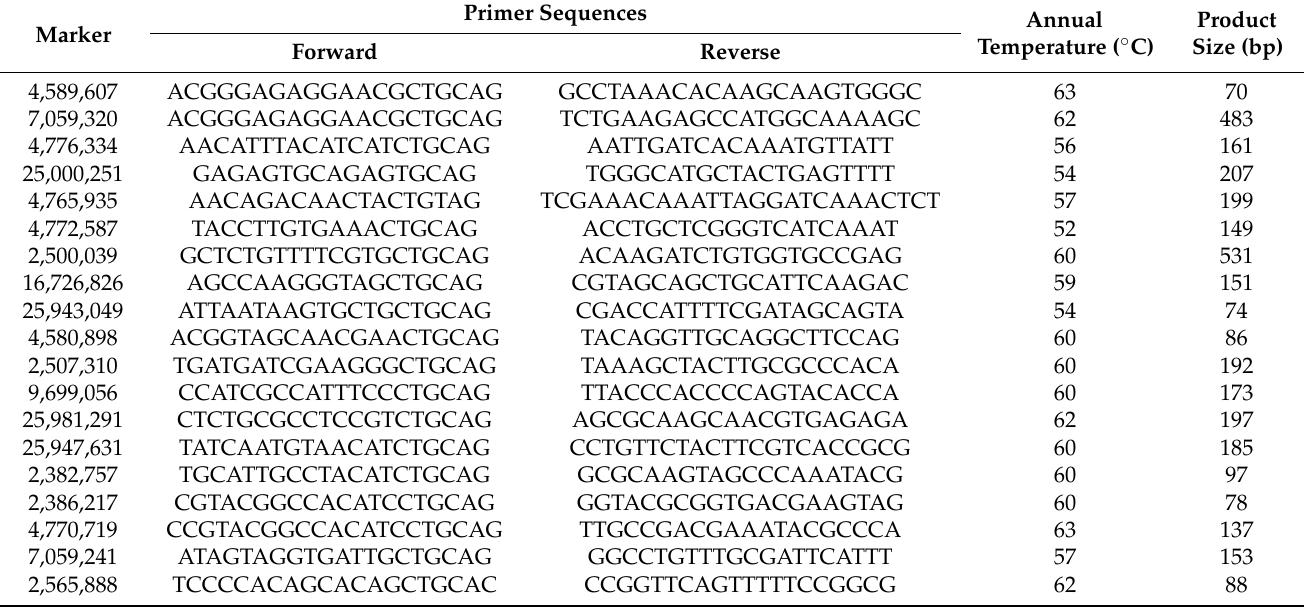
Table 6. Primer sequences to identify markers significantly related to seed vigor and seed germination in